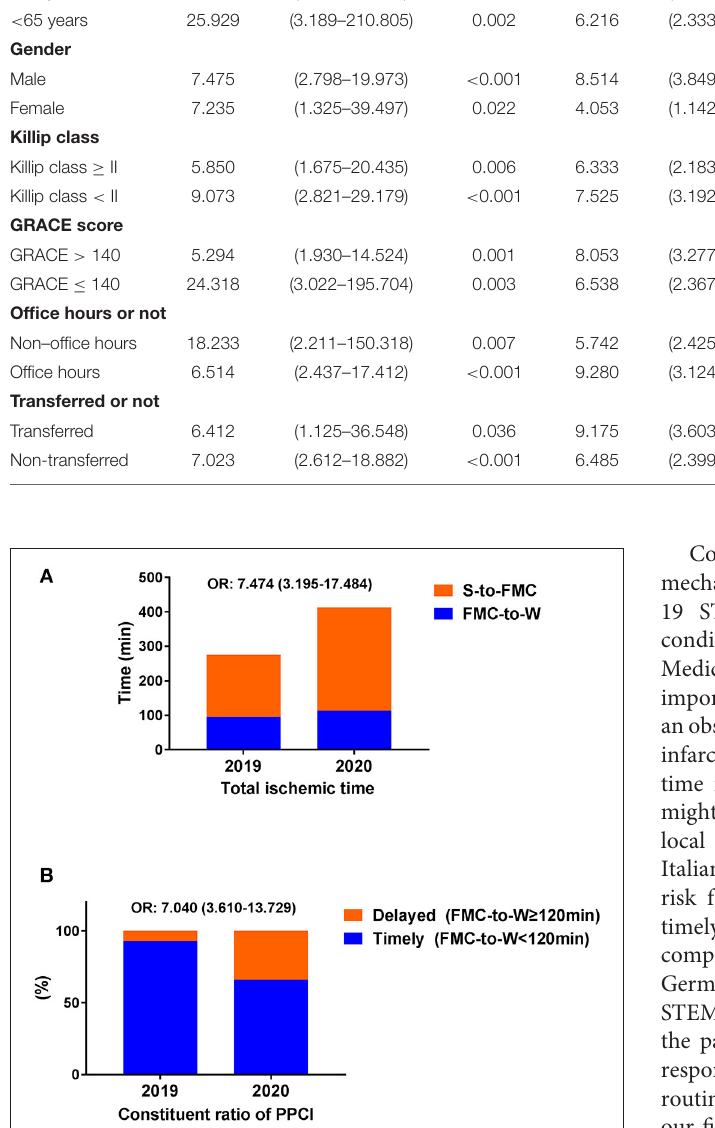
FIGURE 3 | Constituent ratios of TIT and